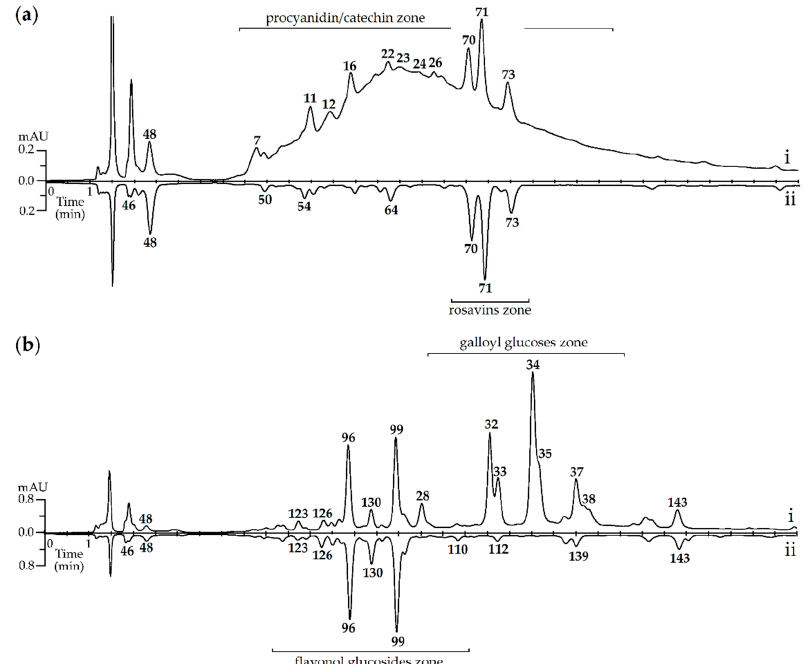
Figure 2. HPLC-DAD chromatograms (detector λ 210 nm) of R. rosea rhizome extract ( a ) and flowers extract ( b ) before (i) and after (ii) incubation with mixture of digestive enzymes